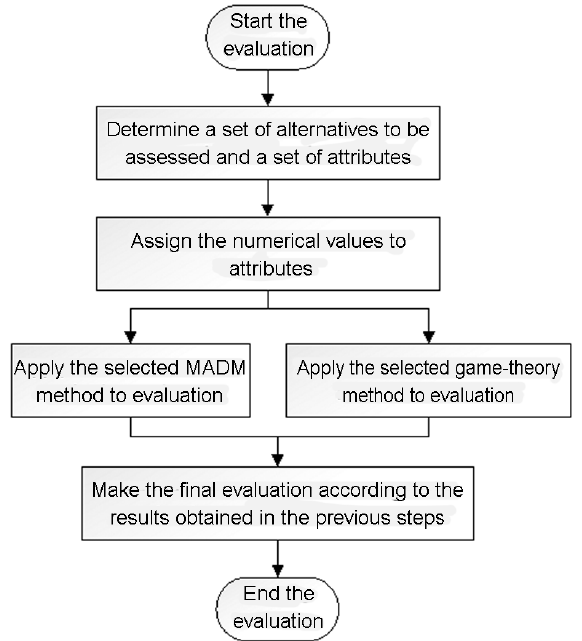
Fig. 1. Complex MADM and game theory-based methods used for evaluating the